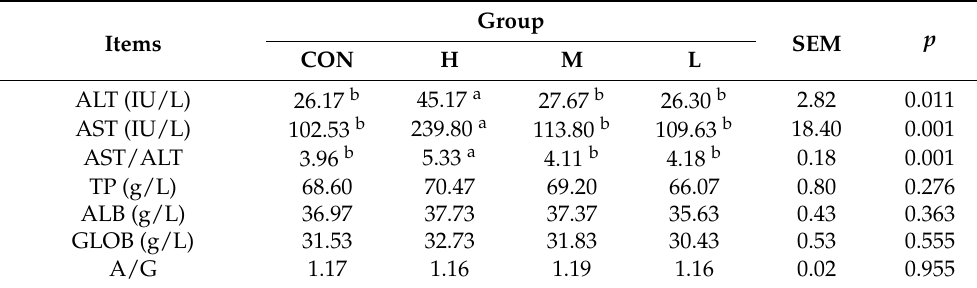
Table 5. Effects of ALE on serum biochemical indices in